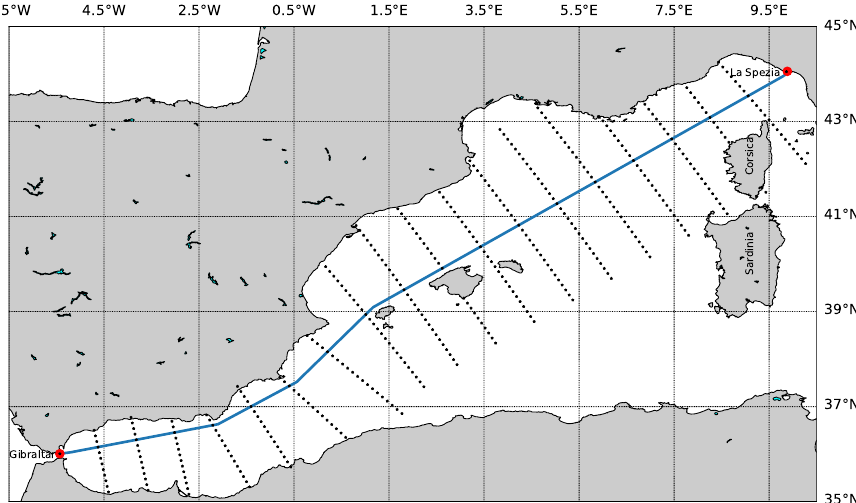
Figure 5. Nominal route between La Spezia (ITA) and Gibraltar (UK) ports provided by searoutes. com [24]. Navigation graph with nodes plotted as black point